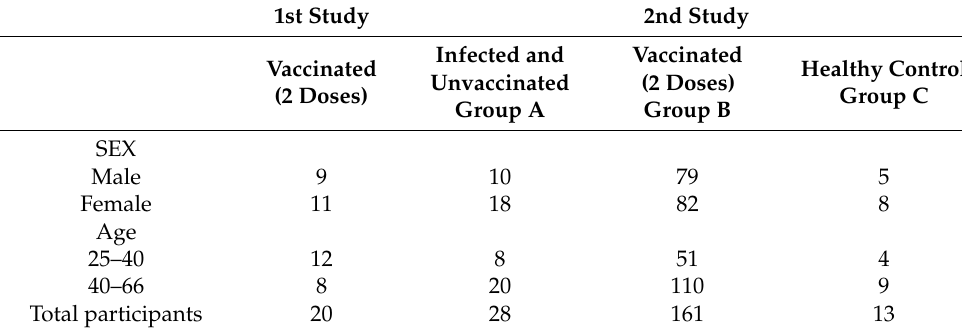
Table 1. Description of pilot